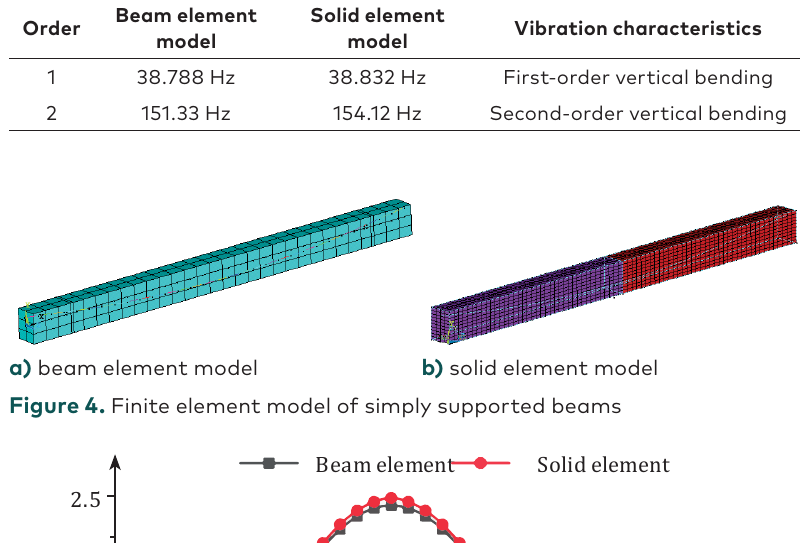
Beam element Solid element